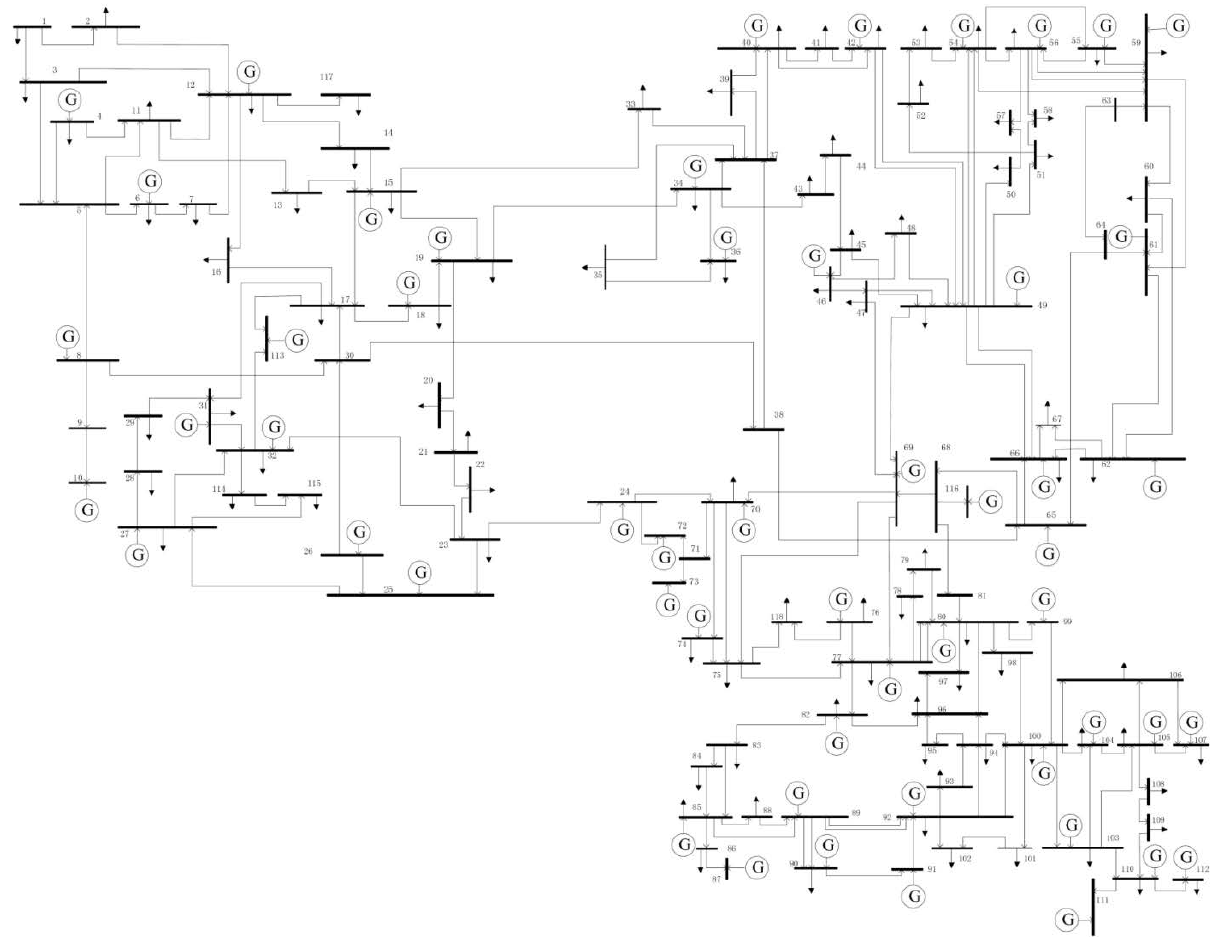
Figure 6. IEEE 118-bus system.